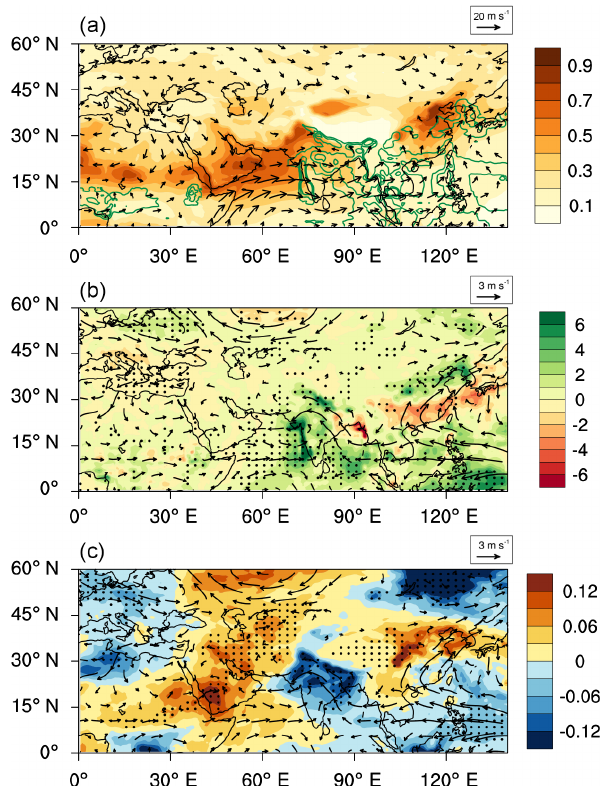
Figure 3. (a) Spatial distributions of climatological AOD dur- ing July to August, superimposed with precipitation (only those >6mmday − 1 are shown) and 850hPa wind (arrows, in ms − 1 ). (b) Spatial distributions of anomalous (“strong” minus “weak”) pre- cipitation (mmday − 1 ) and 850hPa wind (arrows, in ms − 1 ). (c) is same as (b) except the patter is showing anomalous AOD and 850hPa wind (arrows, in ms − 1 ). Dots represent data points with a significance